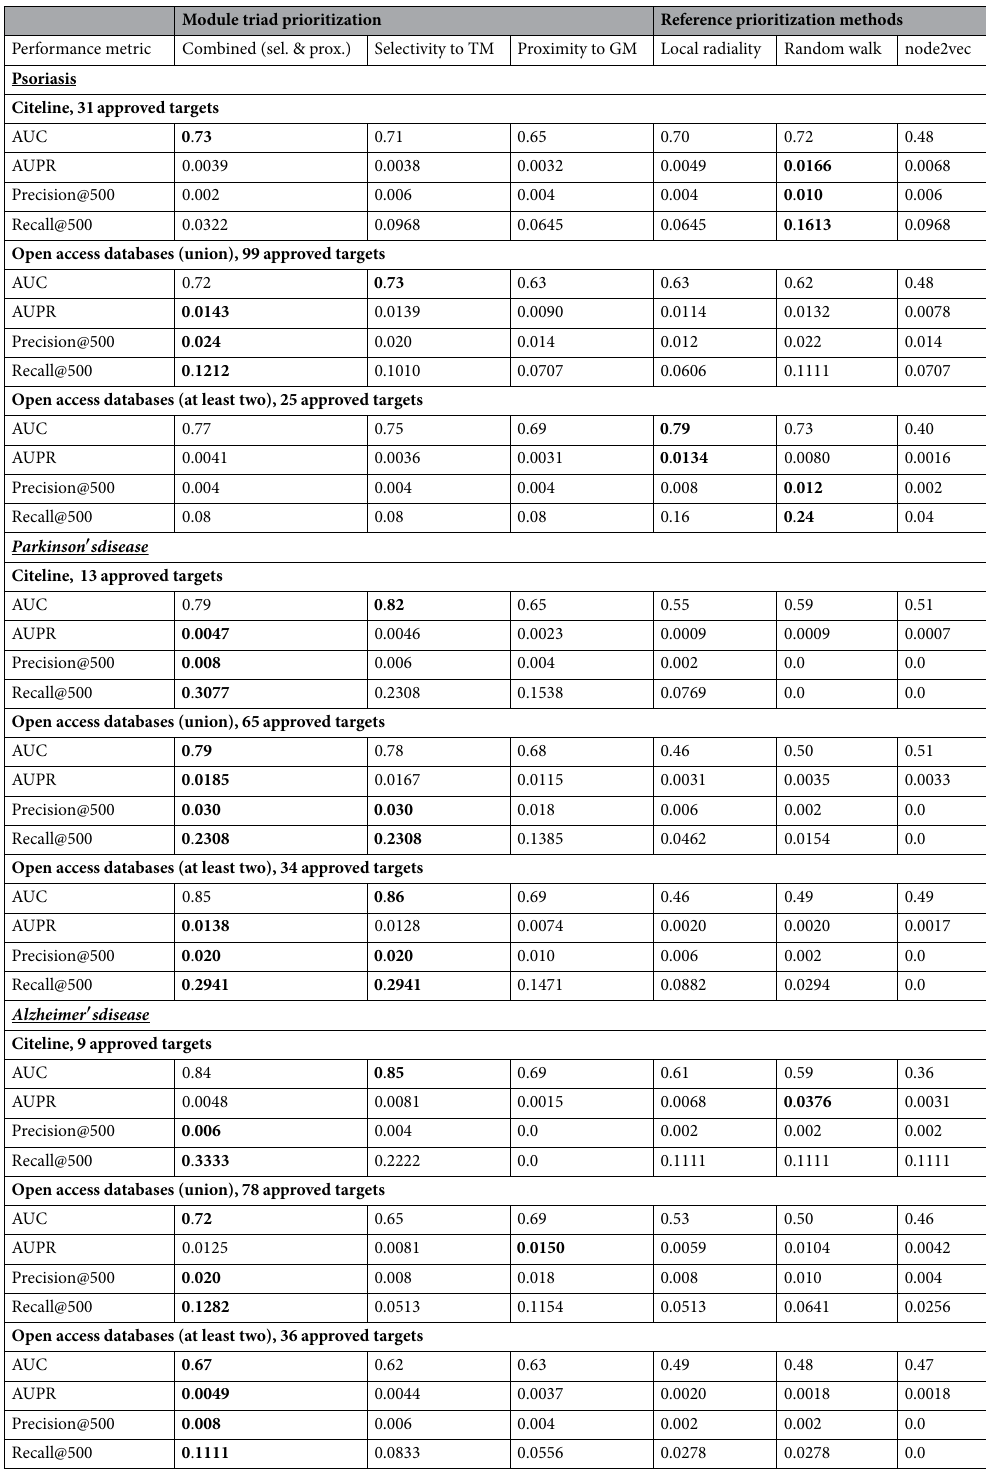
Table 2. Performance of the proposed module triad method and other network-based target prioritization methods on recovery of known approved targets in psoriasis, Parkinson’s disease and Alzheimer’s disease. Known approved targets are derived from Citeline database, as well as the three open access databases. Best performing methods are highlighted in